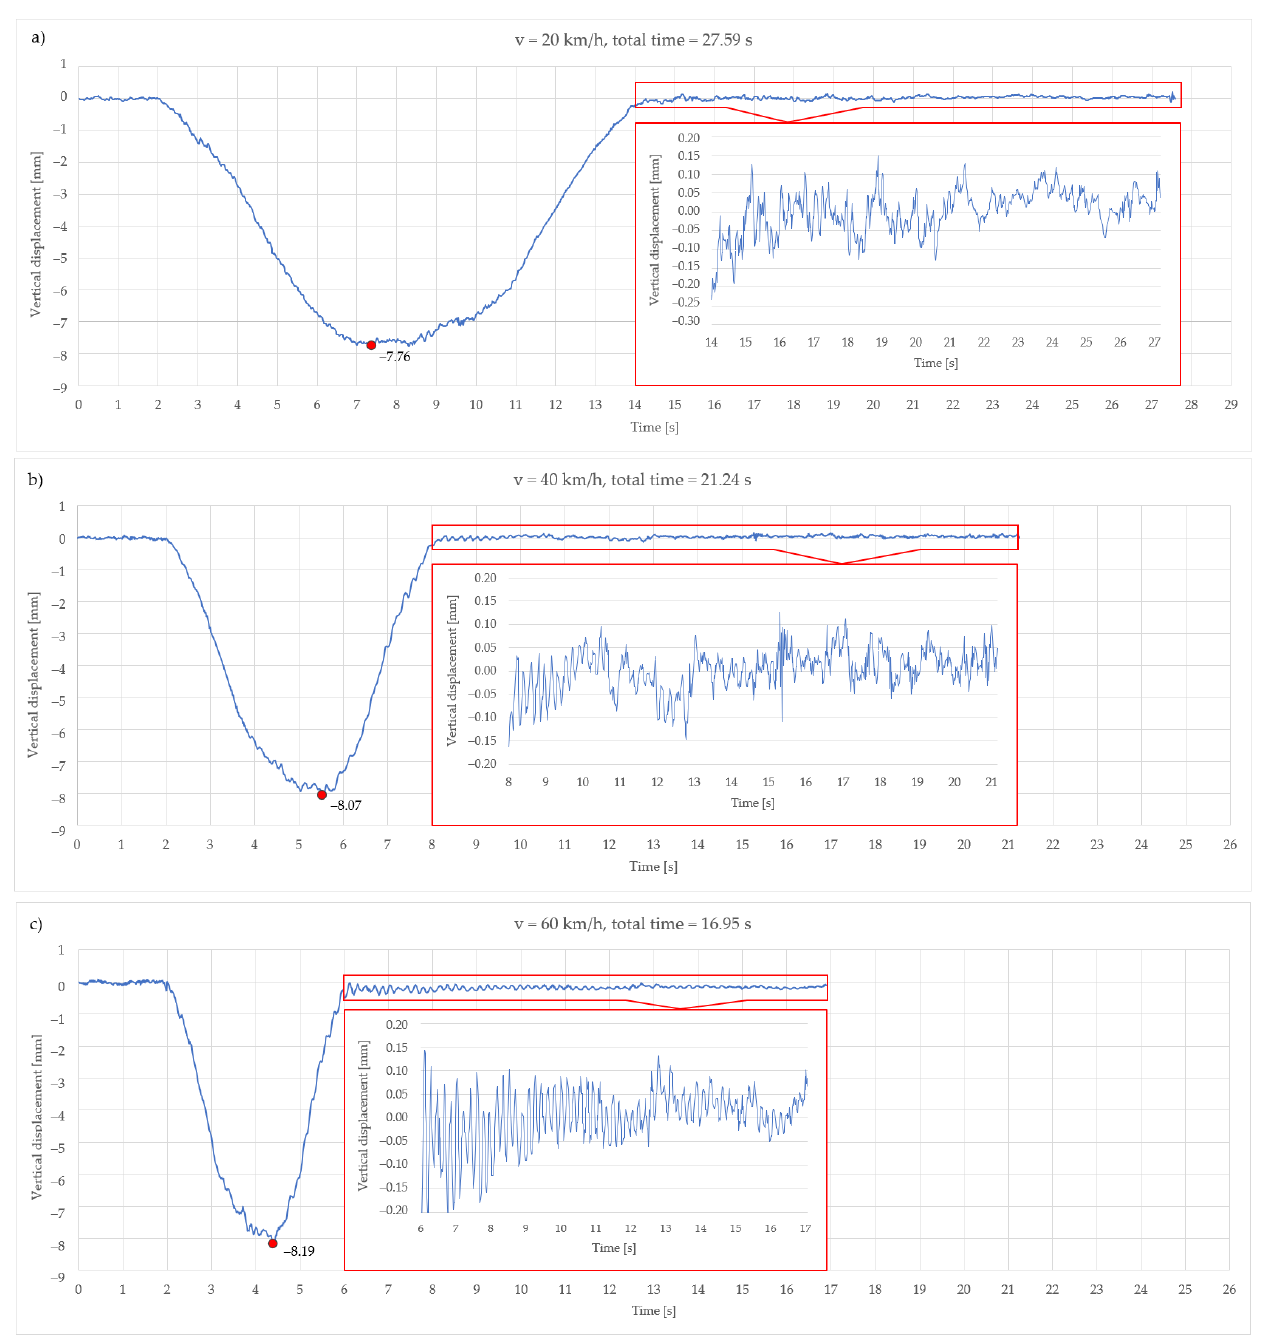
Figure 8. Determined vertical displacements obtained from IATS prototype raw measurement data—vertical displacements in the middle of the bridge span with marked maximum vertical displacement when the train is passing at 20 km/h ( a ), 40 km/h ( b ), and 60 km/h ( c ).